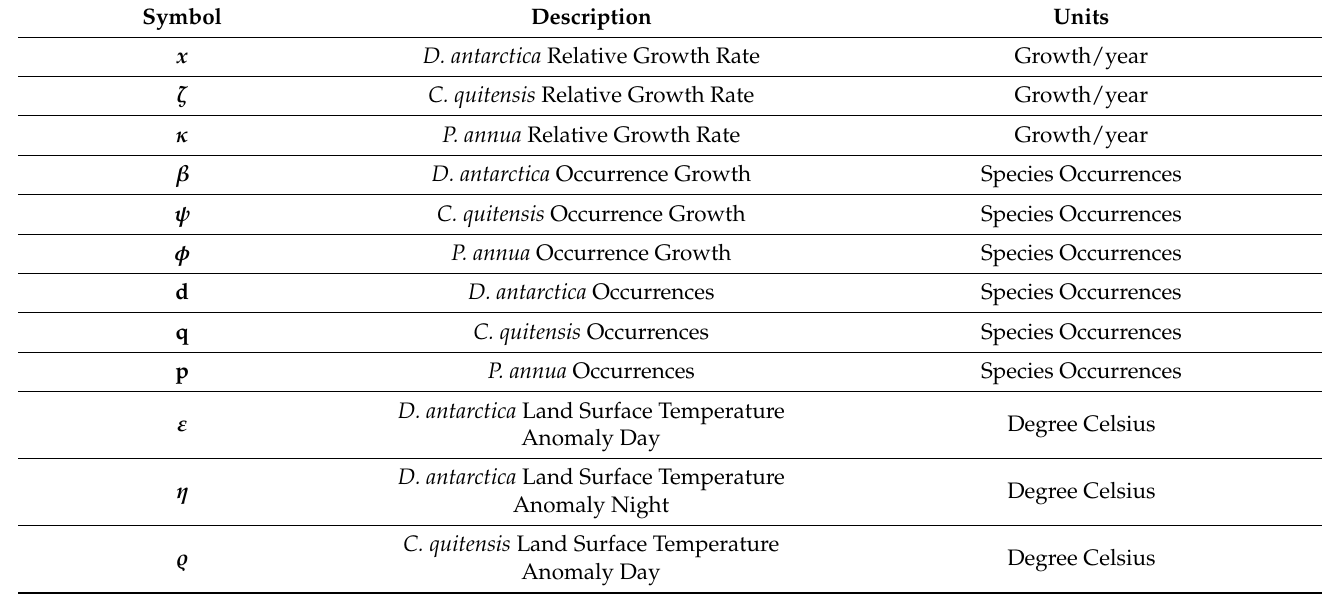
Table 2. Model Parameter Definitions Used in the State Variable Equations and Descriptive Model